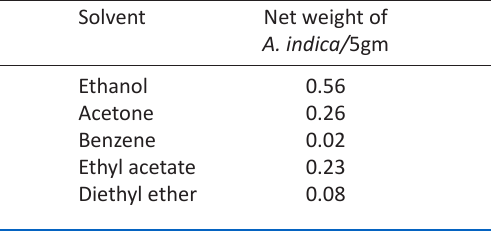
Table 1. Effect of different solvent on A. indica